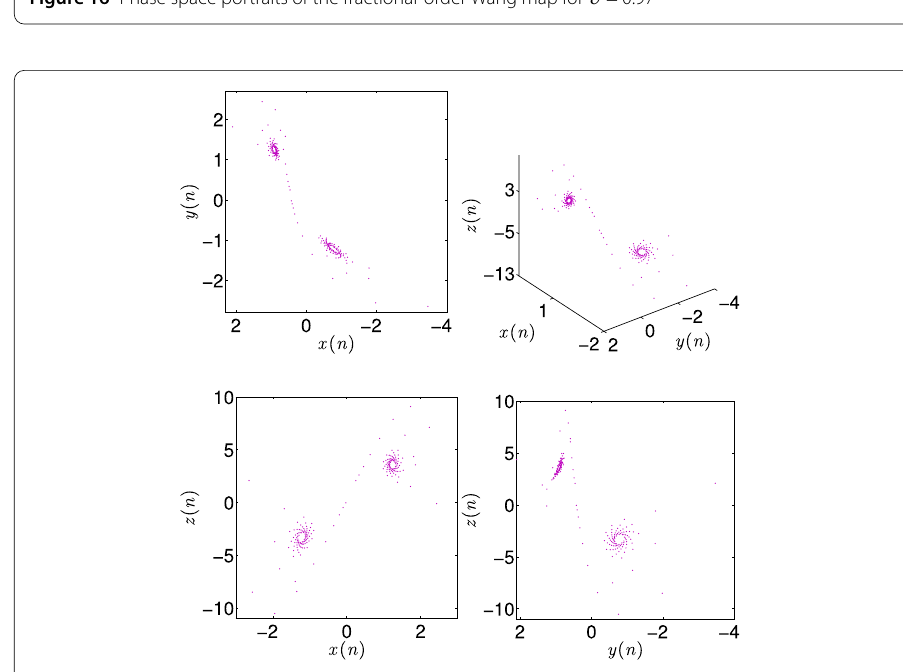
Figure 17 Phase space portraits of the fractional-order Wang map for υ =